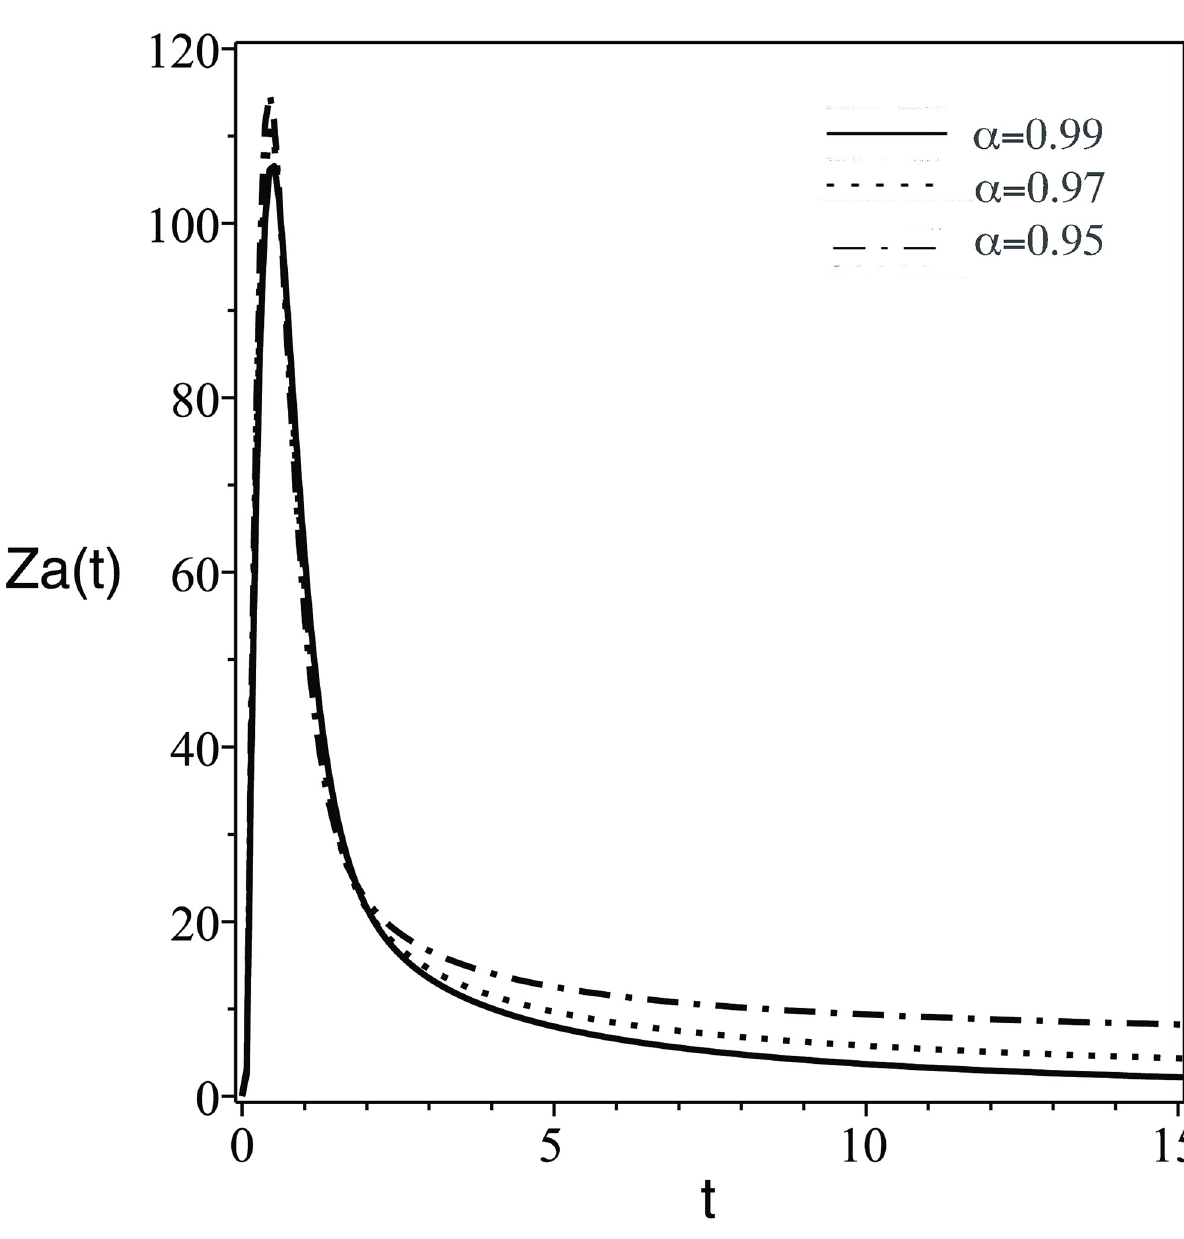
Fig 6. Same as Fig 1 but for the number of activated immune system cells, Z a ( t